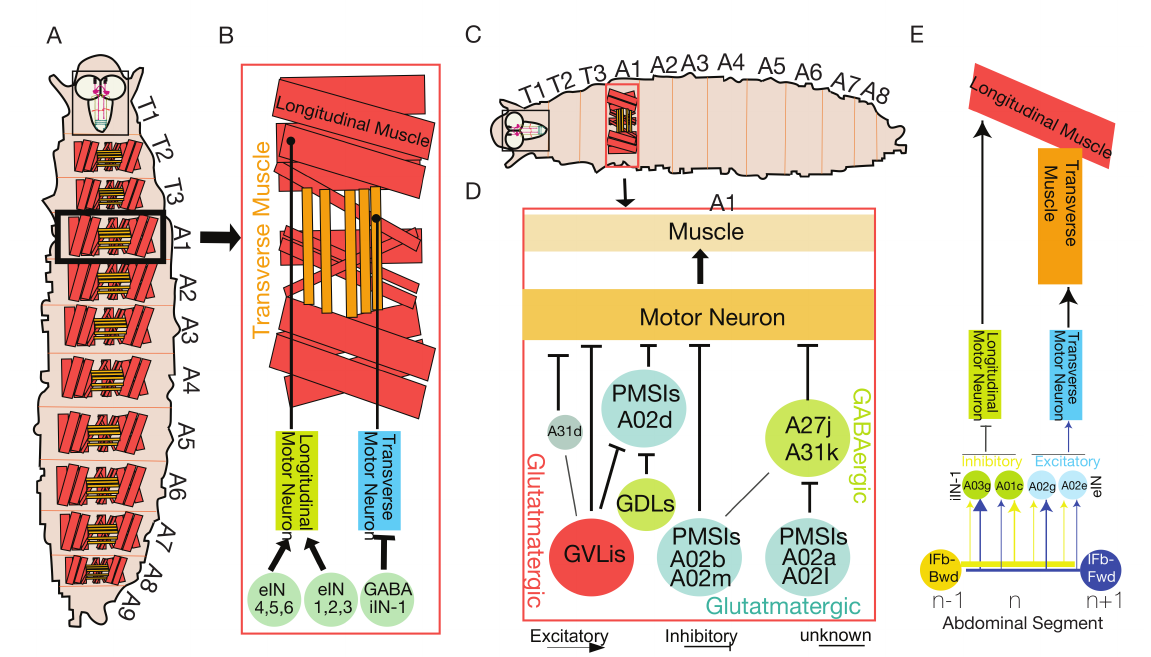
Figure 2. Interneuronal circuits regulating intrasegmental muscle contractions. ( A ) Schematic of Drosophila larva (not to scale) showing the anatomy of interneuronal circuits controlling coordinated longitudinal and transverse muscle segments. ( B ) Schematic showing neuromuscular connectivity (not to scale) of Longitudinal Muscles (LMs) (light red) and Transverse Muscles (TMs) (golden) that are innervated by longitudinal and transverse MNs, respectively (adapted and modified from [13,22]). ( C ) Schematic (not to scale) showing period positive median segmental interneurons (PMSIs) interneuronal circuits controlling MNs bursts duration. ( D ) PMSIs (A02b and A02m) provide inhibitory inputs to MNs. Other sets of PMSIs (A02a, A02I), presynaptic to GABAergic premotor neurons, remove inhibition from MNs after the relaxation of their target muscles. GVLIs inhibit MNs and control the termination of MNs bursting by being active at later phases of the locomotor cycle (adapted from [13,22]). ( E ) Intersegmental feedback neurons Ifb-Fwd and Ifb-Bwd neurons synapse to their target postsynaptic excitatory interneurons (A01c and A03g) that innervate transverse MNs and muscles and inhibitory interneurons (A02e, A02g and A14b) innervate longitudinal MNs and muscles for the regulation of bilateral motor coordination (adapted and modified from